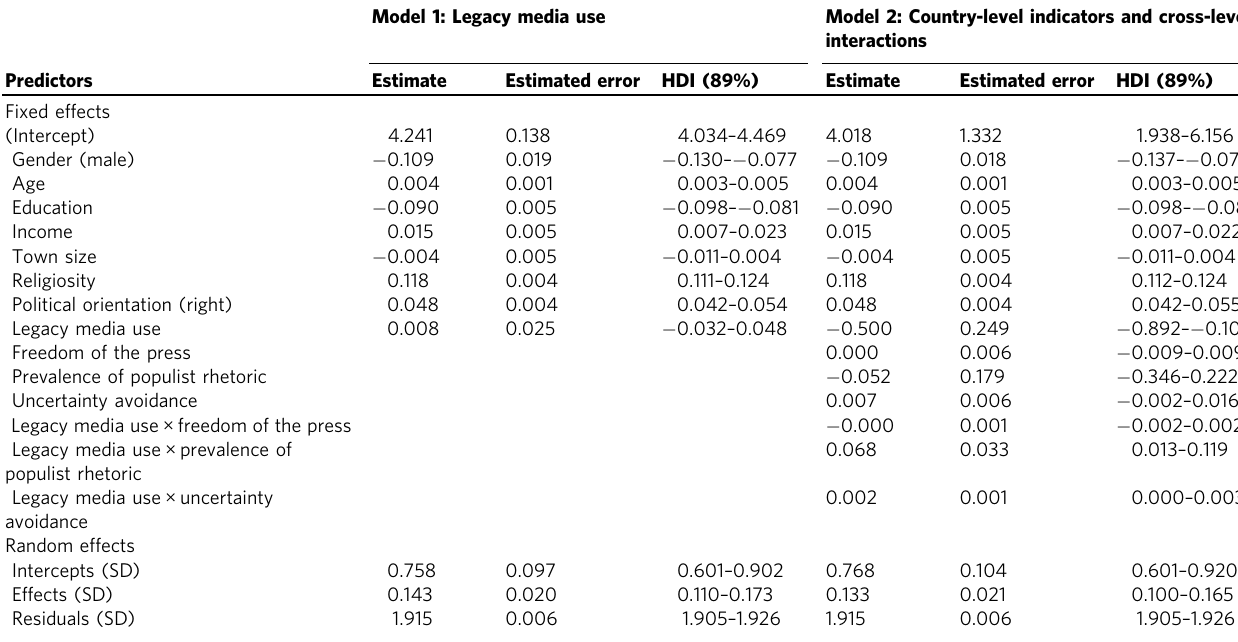
Table 1 Bayesian multilevel models predicting anti-science attitudes across